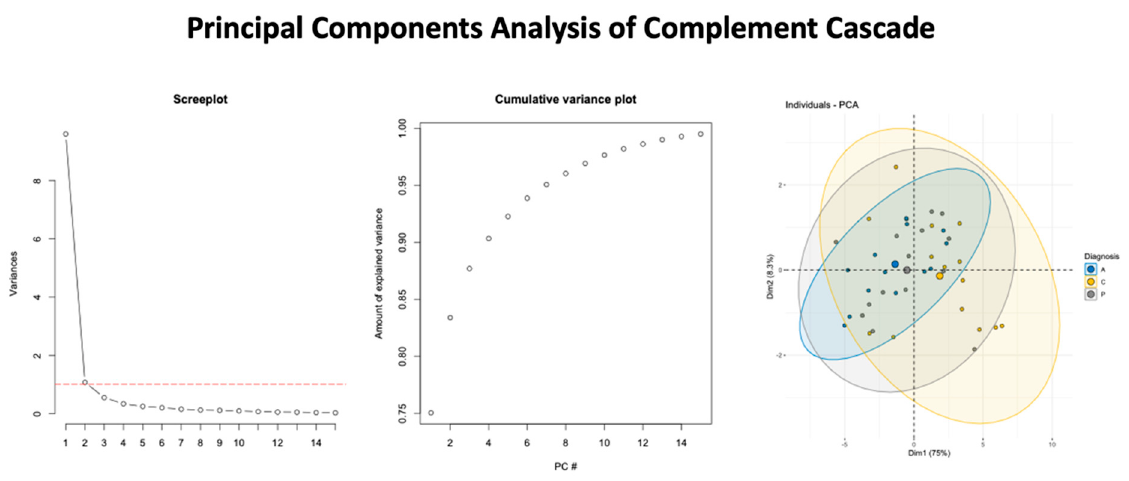
Figure 3. Summary of findings from the Principal Component Analysis. The screeplot ( left panel ), cumulative variance plot ( middle panel ), and the variance from the first two dimensions ( right panel ) with ellipses to identify the respective study cohorts are shown.